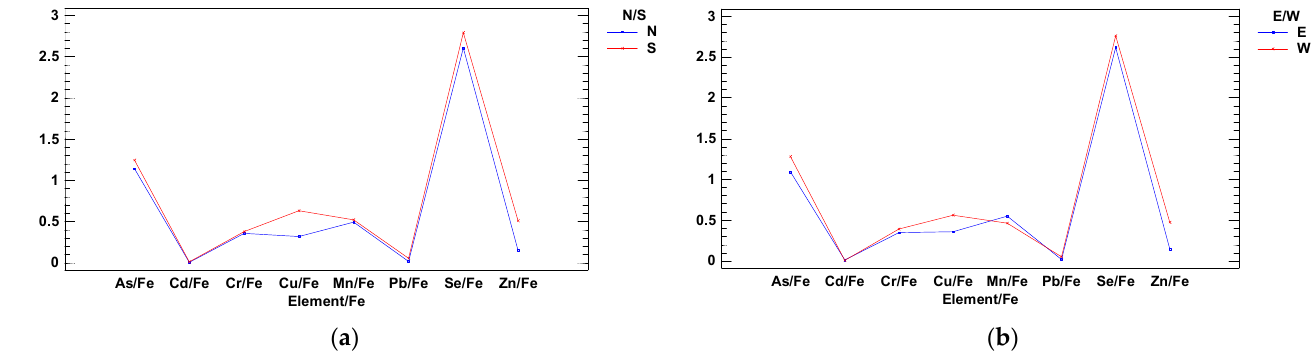
Figure 3. Two-way ANOVA interactions amongst element ratios vs. Fe and cardinal axis (element level/Fe level ratios ( y axis) vs. elements ( x axis)): ( a ) N/S, with Cu/Fe & Zn/Fe higher levels in the south (Vigo harbor) and ( b ) E/W, with Cu/Fe and Zn/Fe higher levels in the west (outer estuary).